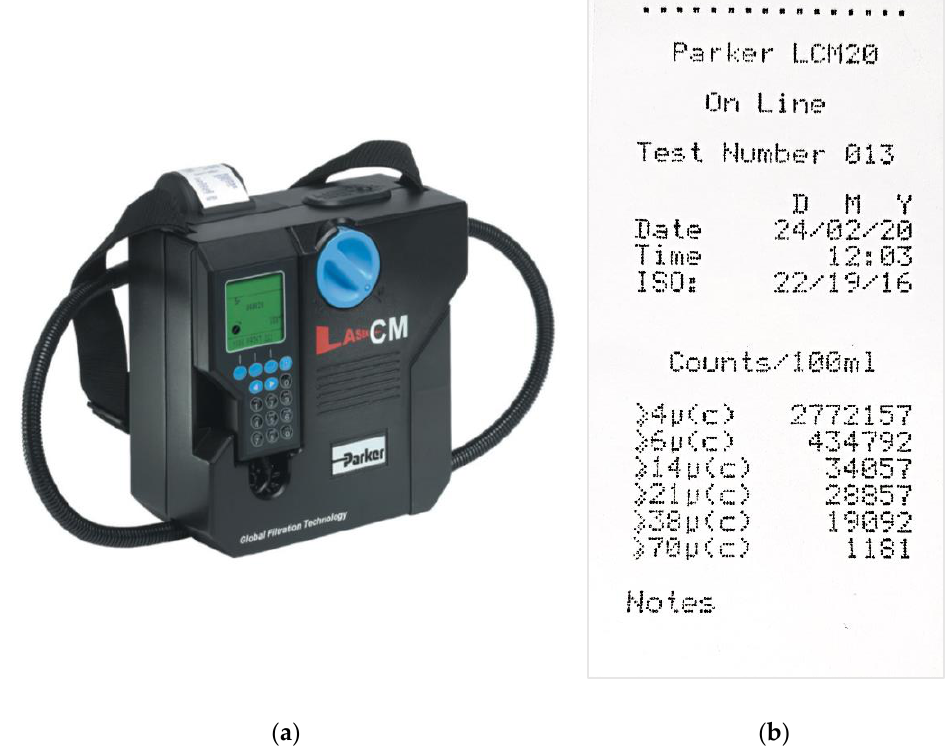
Figure 3. Parker Laser CM20 automatic particle number meter ( a ) device and ( b ) sample printout of measurements.